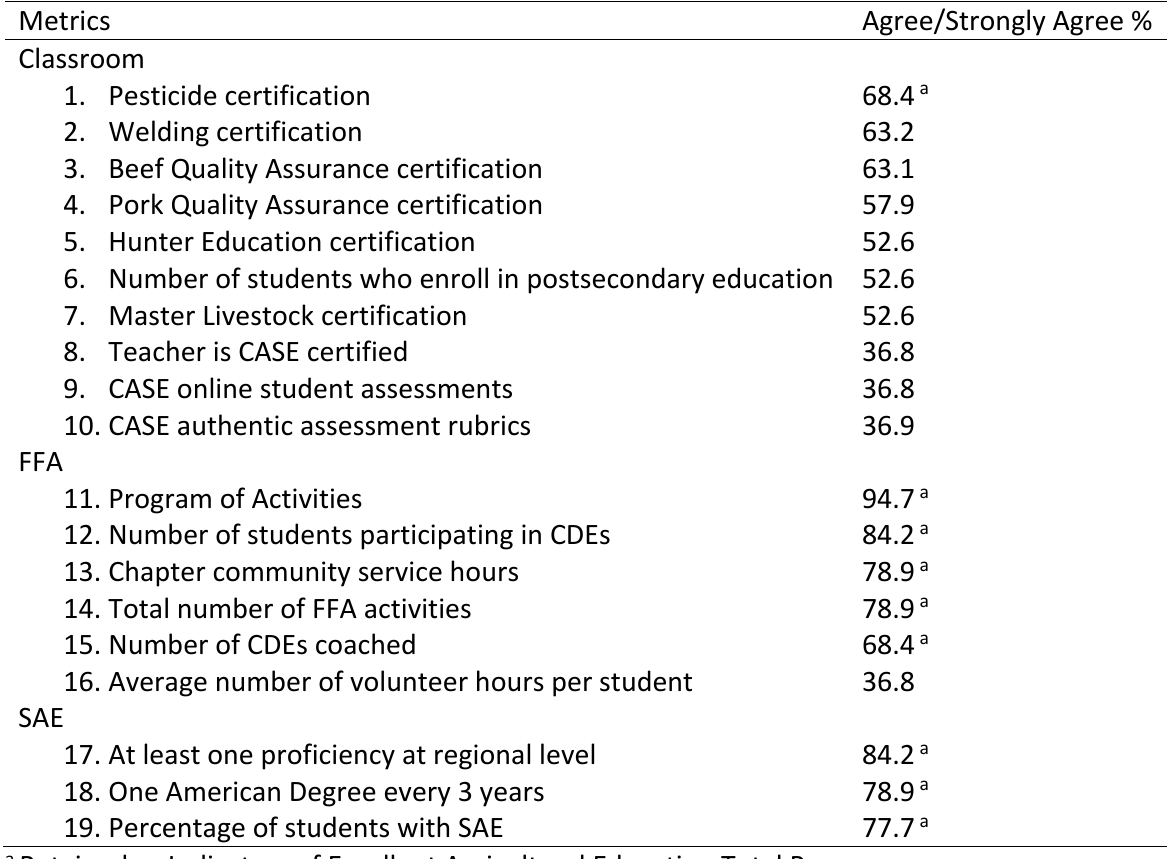
Metrics Suggested in Round 2 as Indicators of Excellent Agricultural Education Programs Metrics Agree/Strongly Agree